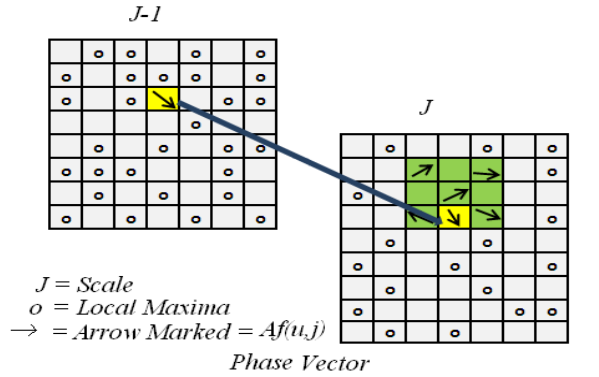
Figure 5. Consent of Modulus maxima lines. Local maxima search for the closest phase maxima in the next